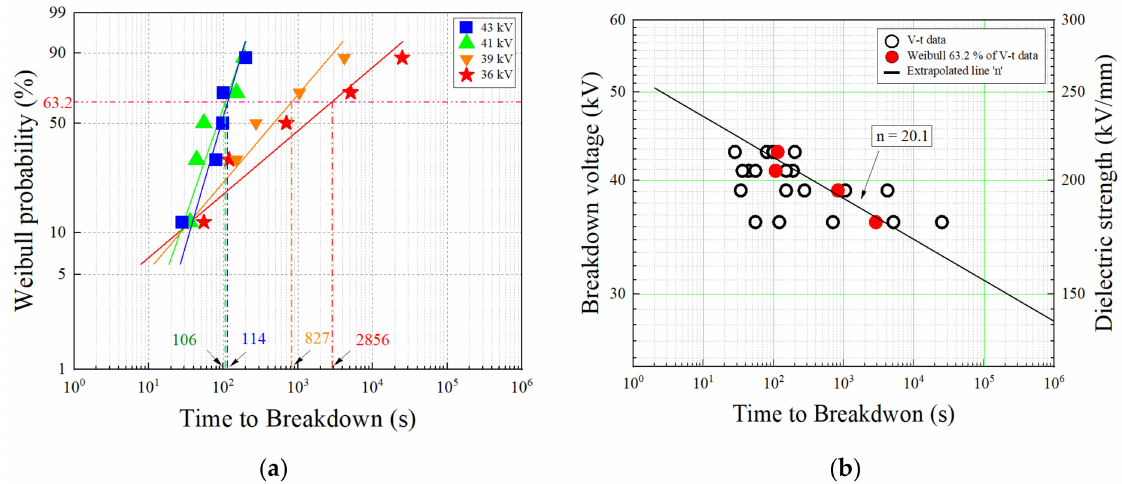
Figure 7. Breakdown data analysis on block copolymer: ( a ) Weibull distribution according to time to breakdown; ( b ) V-t graph to obtain life exponent and life estimation